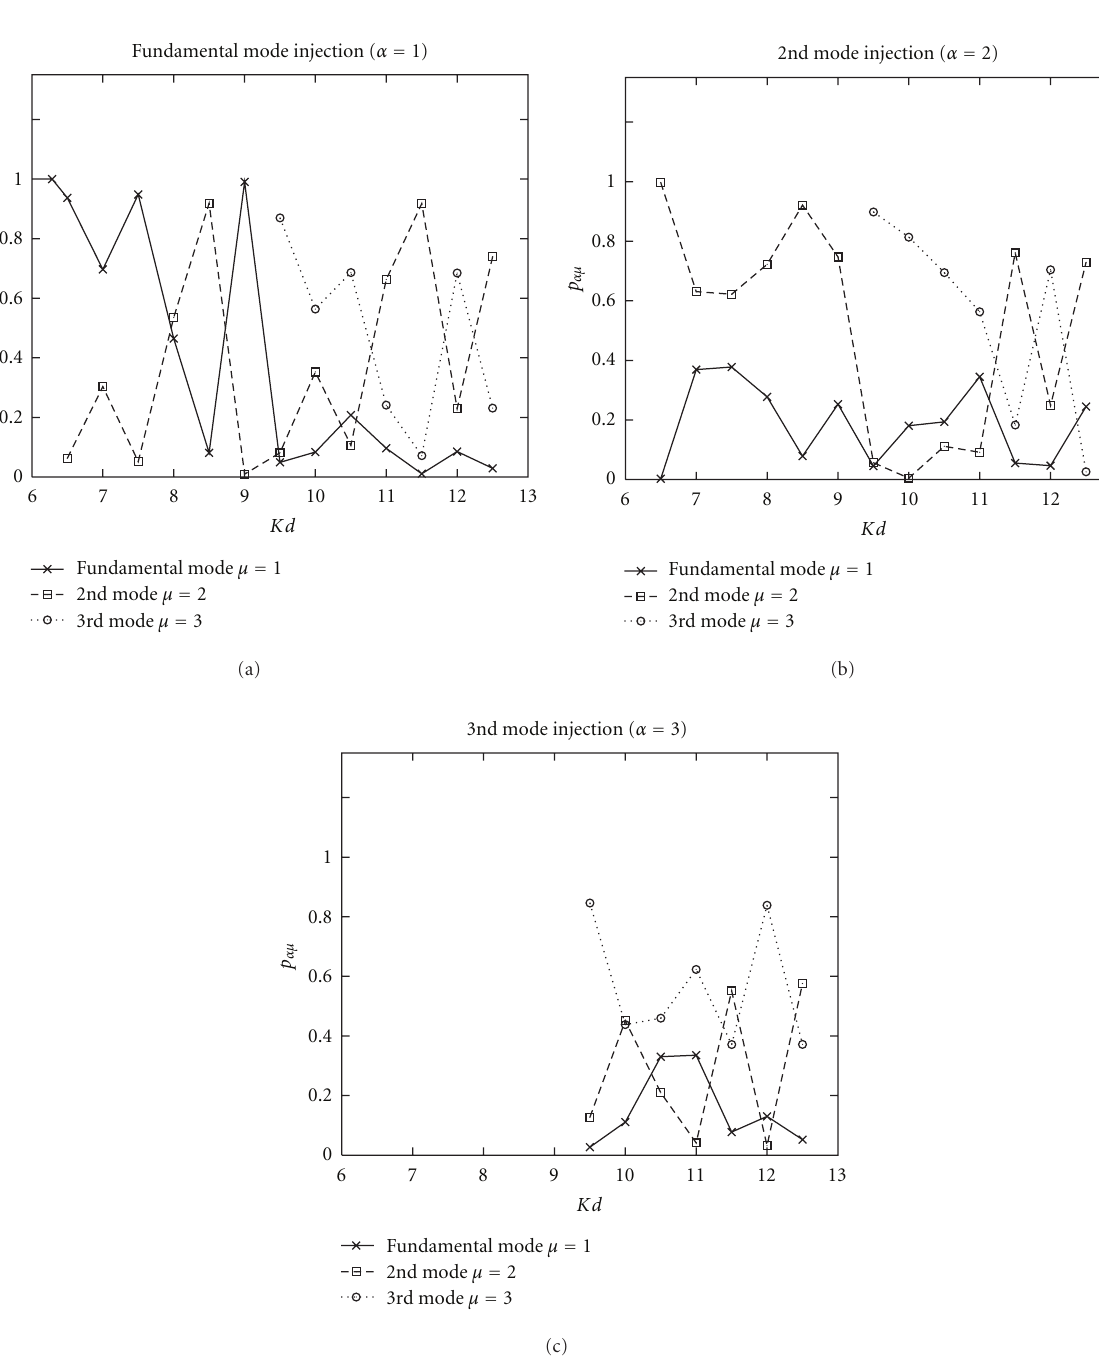
Figure 21: Wavenumber dependence of the fraction p αμ in the transmission current carried by each propagating mode μ when each propagating mode α is injected. The size of the dot is set as r/d =